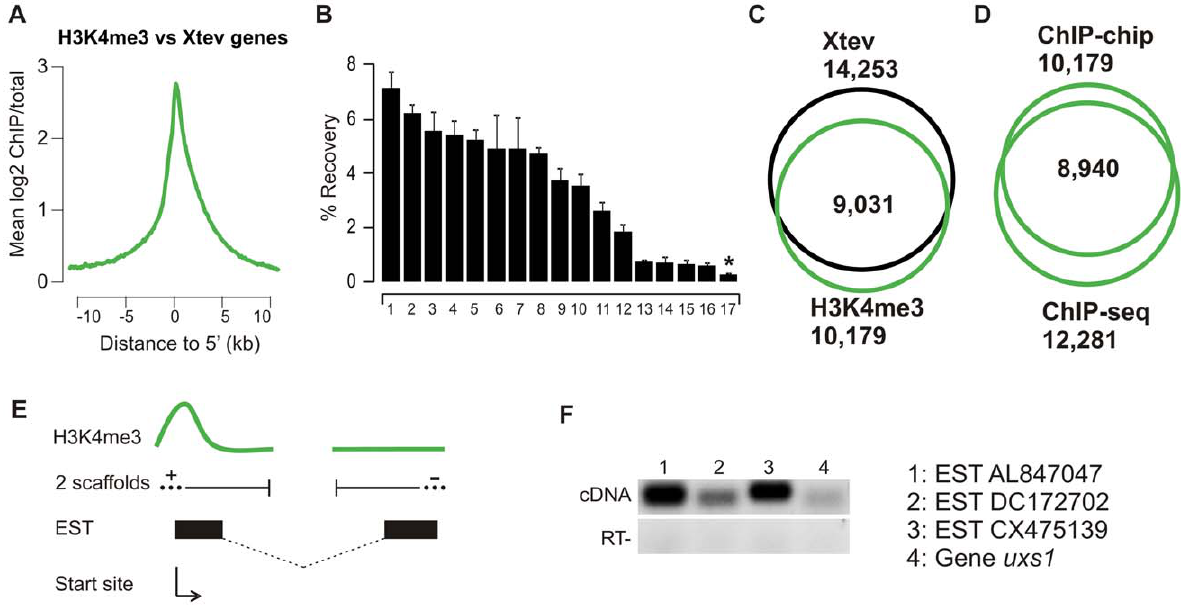
Figure 3. Analyses of H3K4me3 triplicate. ( A ) Distributions of H3K4me3 at annotated Xtev genes. ( B ) ChIP-qPCR validation of randomly selected enriched H3K4me3 regions on three new generated biological replicates. 16 out of 17 of H3K4me3 enriched regions are validated as true positives with an average enrichment . 2.5-fold over background (genomic locus on scaffold_1:6458583-6458633). Asterisk indicates a locus with , 2.5-fold enrichment (experimental FDR , 0.06). Error bars represent the SEM of three independent ChIP experiments. ( C ) Overlap of H3K4me3-enriched regions and Xtev genes (p , 10 2 25 ). ( D ) Overlap of H3K4me3 ChIP-chip and ChIP-seq peaks. Of the peaks found with ChIP-chip, 88% are also detected with ChIP-seq [9] (p , 10 2 25 ). ( E ) ‘Orphan’ H3K4me3 peaks linking different scaffolds. Schematic overview of orphan linkage of two scaffolds using H3K4me3 signals and the EST database. The start site is determined by the H3K4me3 peak and the transcription unit combined with the EST information of the other scaffold. ( F ) RT-PCR validation of ESTs linking two scaffolds using primers that align to two different scaffolds: scaffold 649 and 145 (EST AL847047), scaffold 675 and 1278 (EST DC172702), scaffold 716 and 1312 (EST CX475139) and scaffold 1393 and 307 (uxs1). cDNA used for validation was generated from RNA isolated from stage 11–12 embryos.